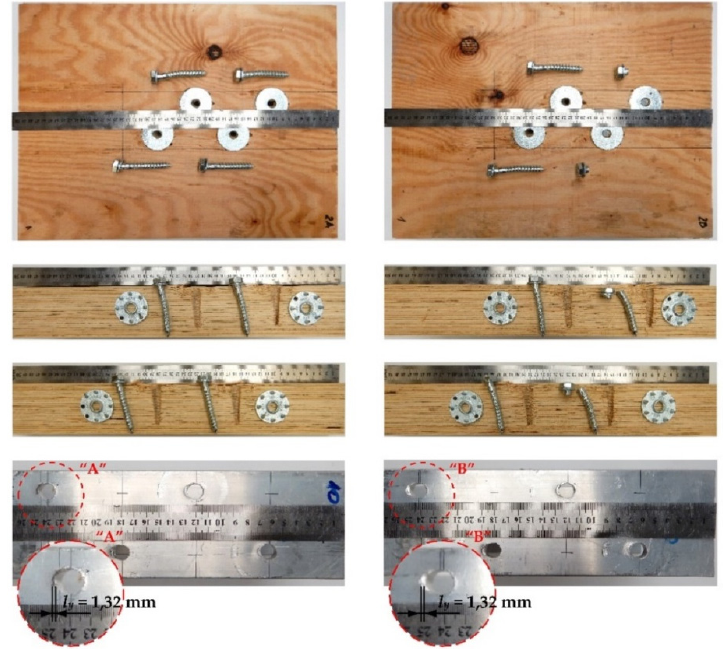
Figure 14. The mode of failure of the aluminium-timber connection with the 12 mm screws and the reinforcing toothed plates (C11-50/M12, Geka).